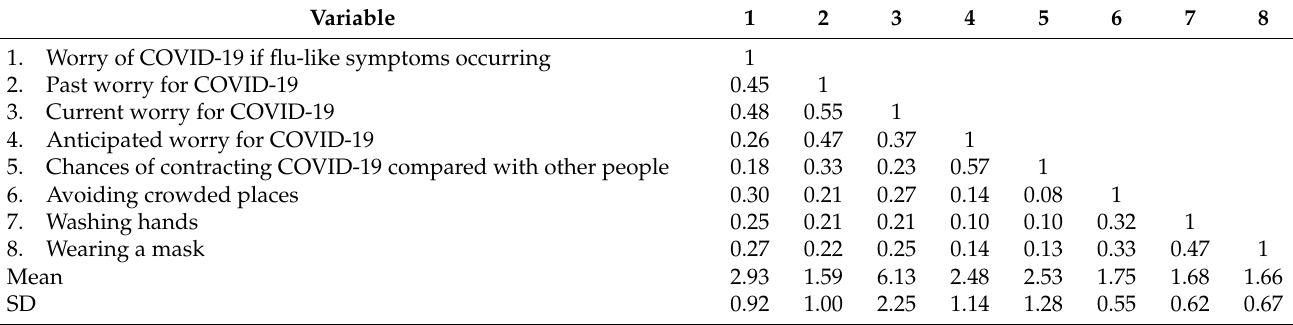
Table 1. Descriptive statistics and correlations between study variables (N =